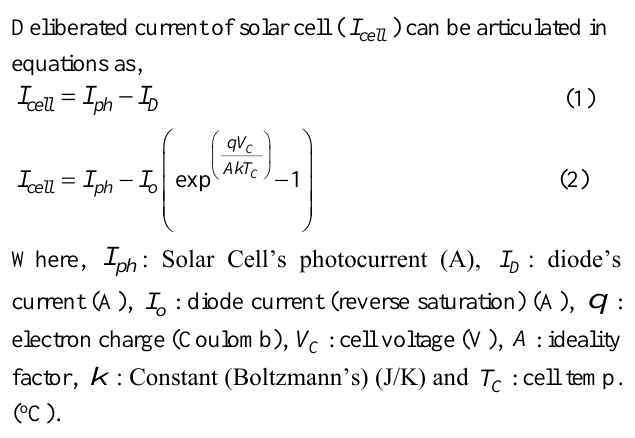
I ) can be articulated in ce ll